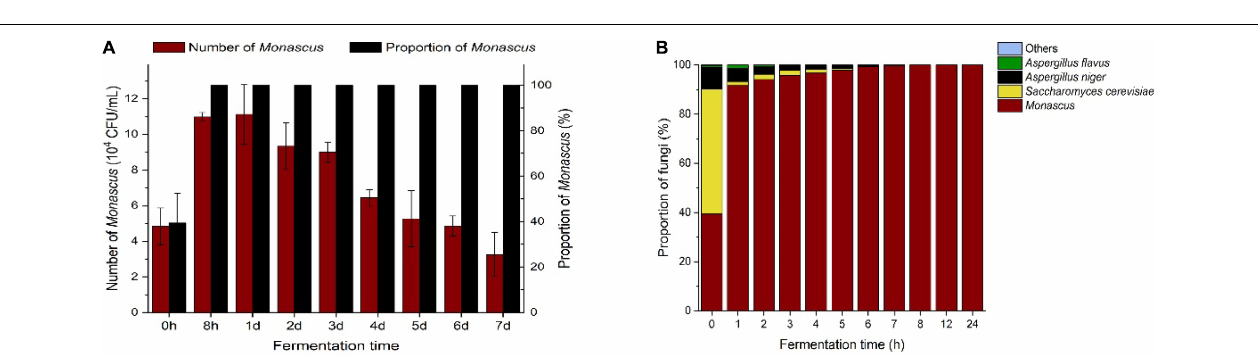
FIGURE 3 | Response surface optimization of lactic acid and ethanol addition in restrictive medium. Hongqu BHQ33 was added to the restrictive medium containing different concentrations of lactic acid and ethanol for fermentation at 30 ◦ C and 200 r/min for 7 days, the number of viable Monascus spores (A) and the proportion of the number of Monascus (B) were calculated after the fermentation broth was diluted and spread on the modified PDA medium to culture for 4 days at 30 ◦ C.